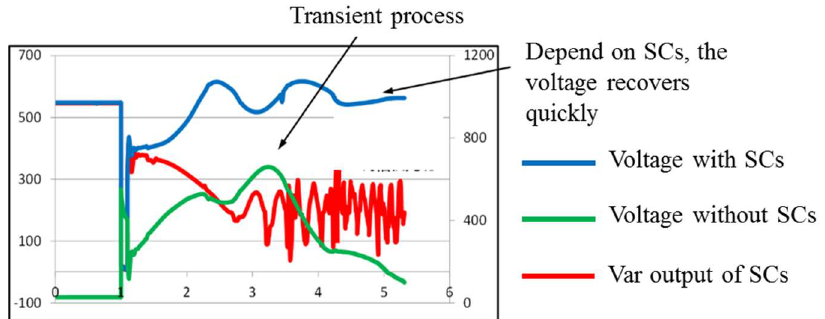
Figure 2. Performance comparison with/without SCs inclusion.